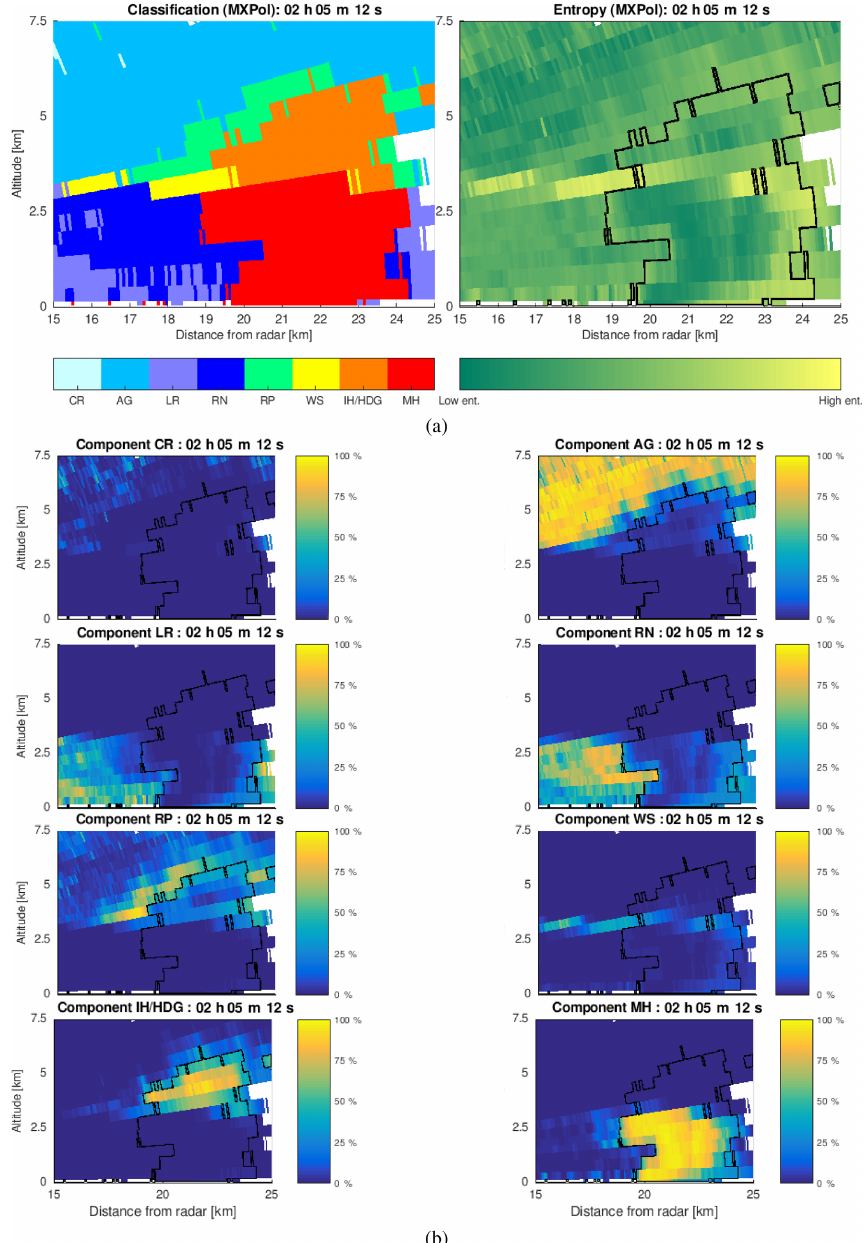
Figure 10. Bin-based de-mixing applied to an example MXPol dataset acquired during the HyMeX campaign in the region of Ardèche, France, on 24 September 2012: (a) classification followed by the entropy estimate, (b) proportion of eight hydrometeor classes in each of the radar sampling